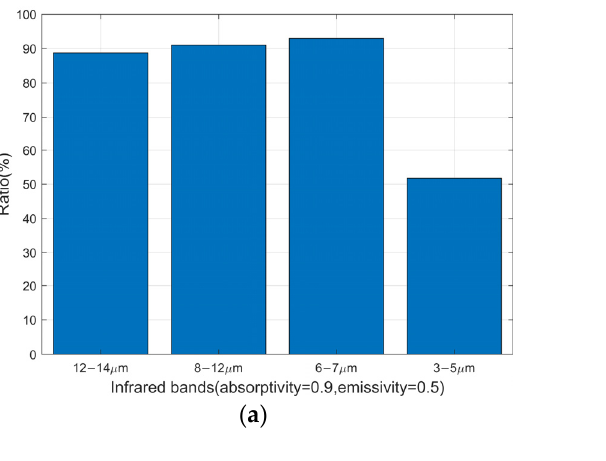
Figure 4. The ratios of self-radiation to the total radiation. ( a ) the ratios in different infrared bands(absorptivity = 0.9, emissivity); ( b ) the ratios within 3–5 µ m. Table 3. Statistics of dominant results of different band combinations.